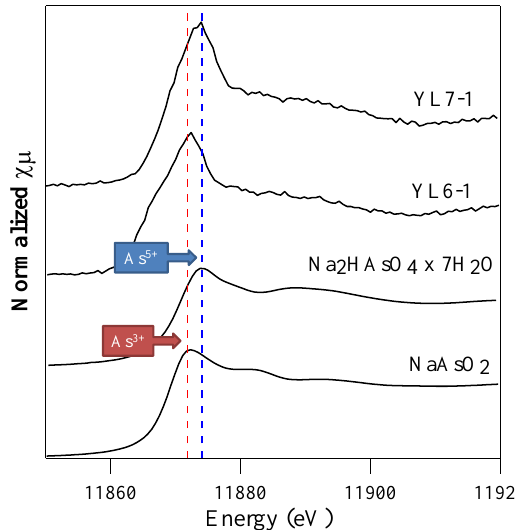
Fig. 7. Normalized As XANES spectra data of the sediments from YL6-1 (16m) and YL7-1 (18m) used in the leaching ex- periments. Referenced As 3 + and As 5 + standards are NaAsO 2 and Na 2 HASO 4 × 7H 2 O,